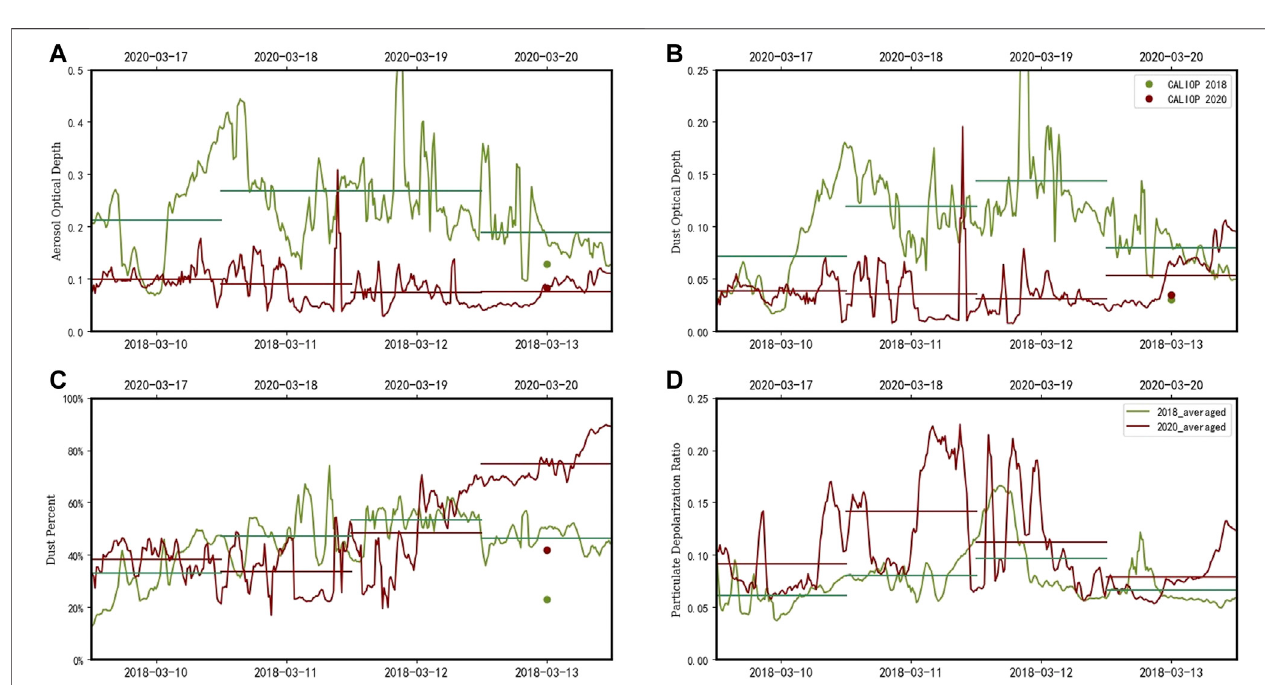
FIGURE 9| The AOD (A) , thedustoptical depth (B) , the percentage of the dust (C) and the particulate depolarization ratio (D) detected by the ground-based lidar (green in 2018 and red in 2020), the horizontal solid line shows the daily mean value respectively in different years. (The green and red dots in the fi gure indicate the corresponding data obtained from CALIOP in 2018 and 2020. The distance between the railway and the ground-based station is within 100 km)